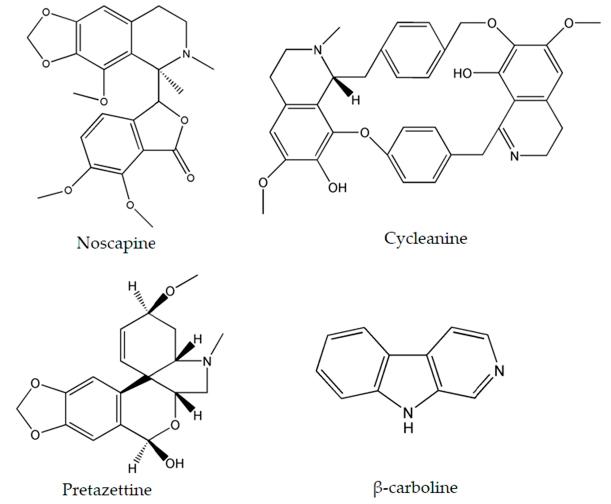
Figure 3. Chemical structures of noscapine, cycleanine, pretazettine and β -carboline.